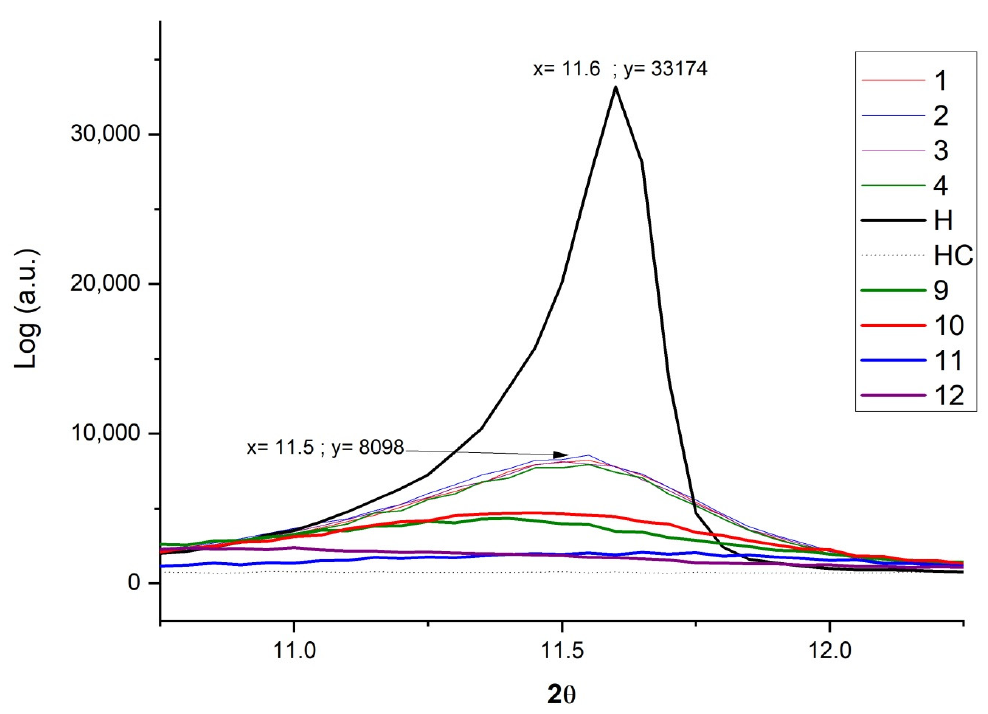
Figure 11. XRD for hydrotalcite, hydrotalcite calcinated, Samples 1–4 and Samples 9–12.